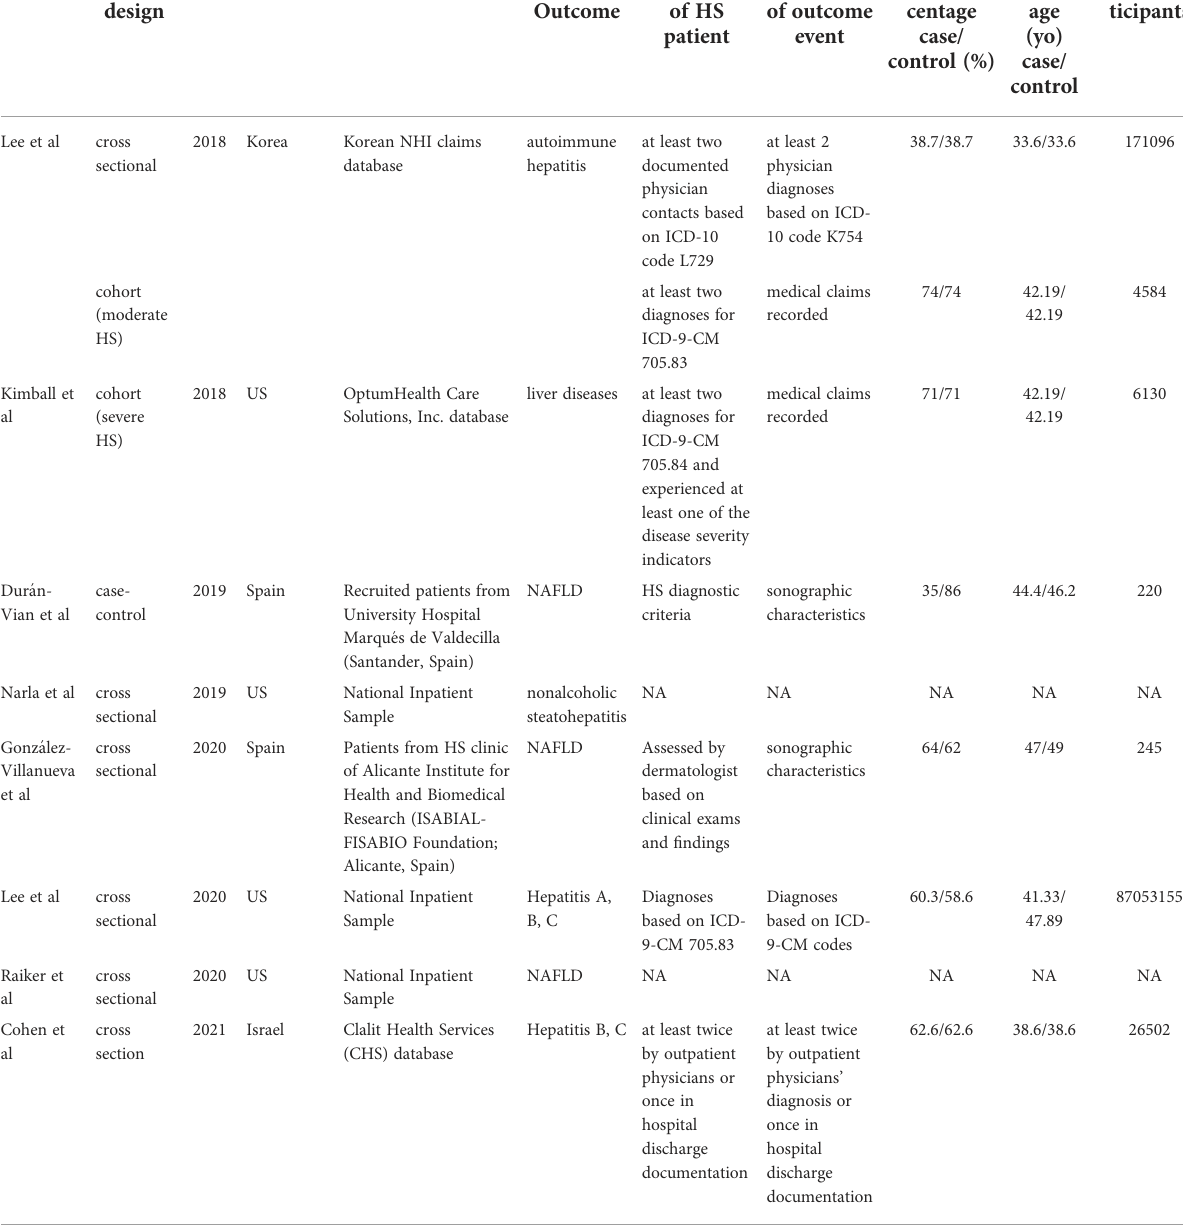
TABLE 1 Characteristics of included